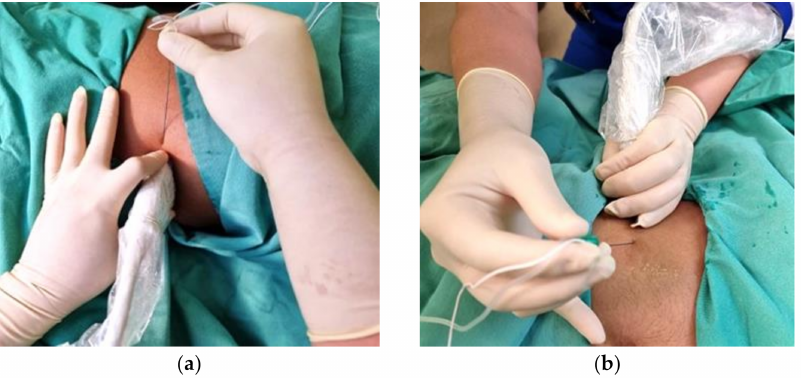
Figure 8. ( a ) Pinch grip while holding a probe will cause muscle strain. ( b ) Palmar grip while